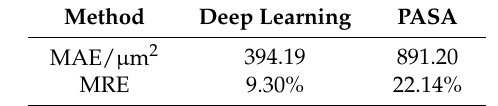
Table 4. Comparison between deep learning method and photoacoustic spectral analysis (PASA)